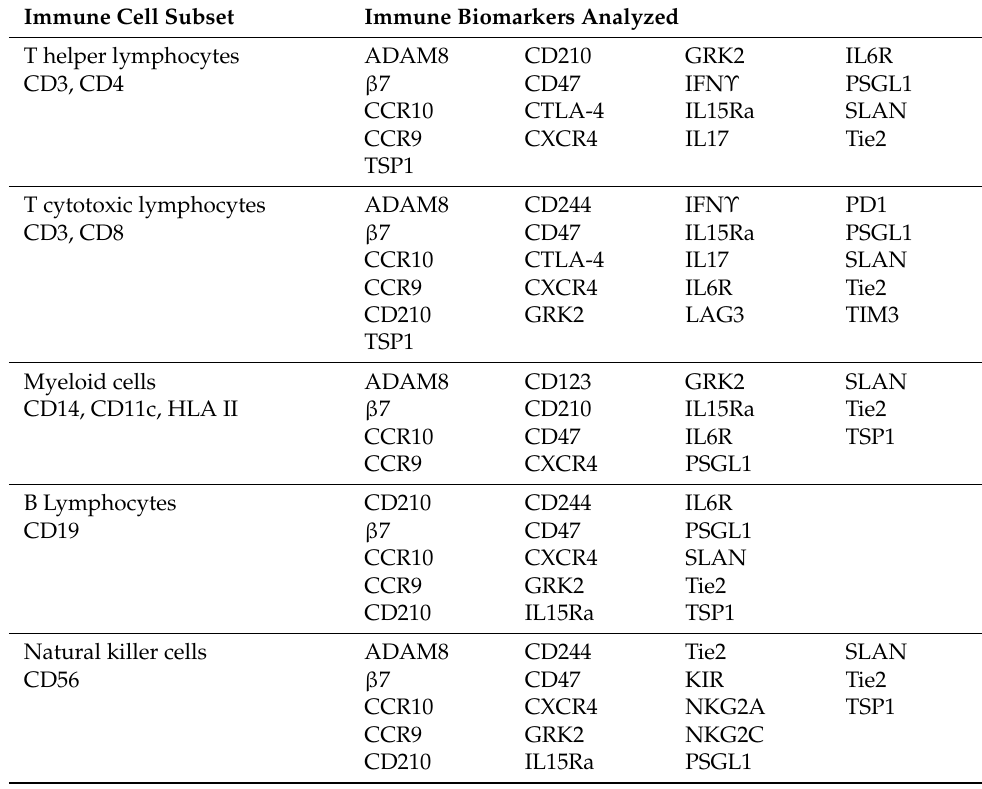
Table 1. Immune biomarkers used for phenotypic characterization of immune cell subsets. Different subpopulations of interest were studied, up to a total of 107, through the expression or not of these basic biomarkers, making multiple combinations with